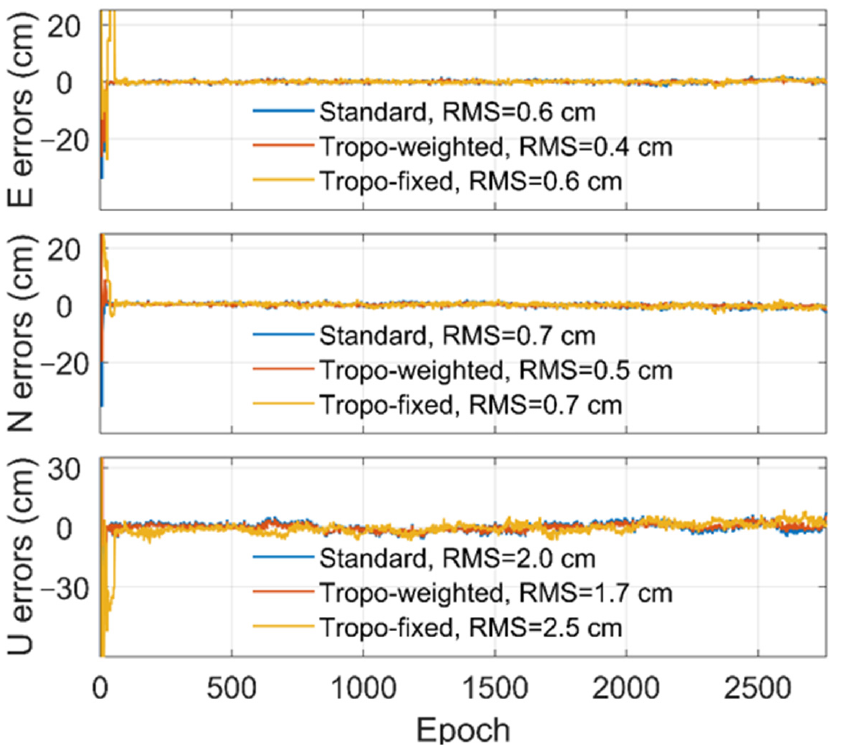
Figure 5. Ambiguity-fixed solutions of East, North, and Up component of the user station NCWA under the standard, tropospheric-weighted, and tropospheric-fixed model.